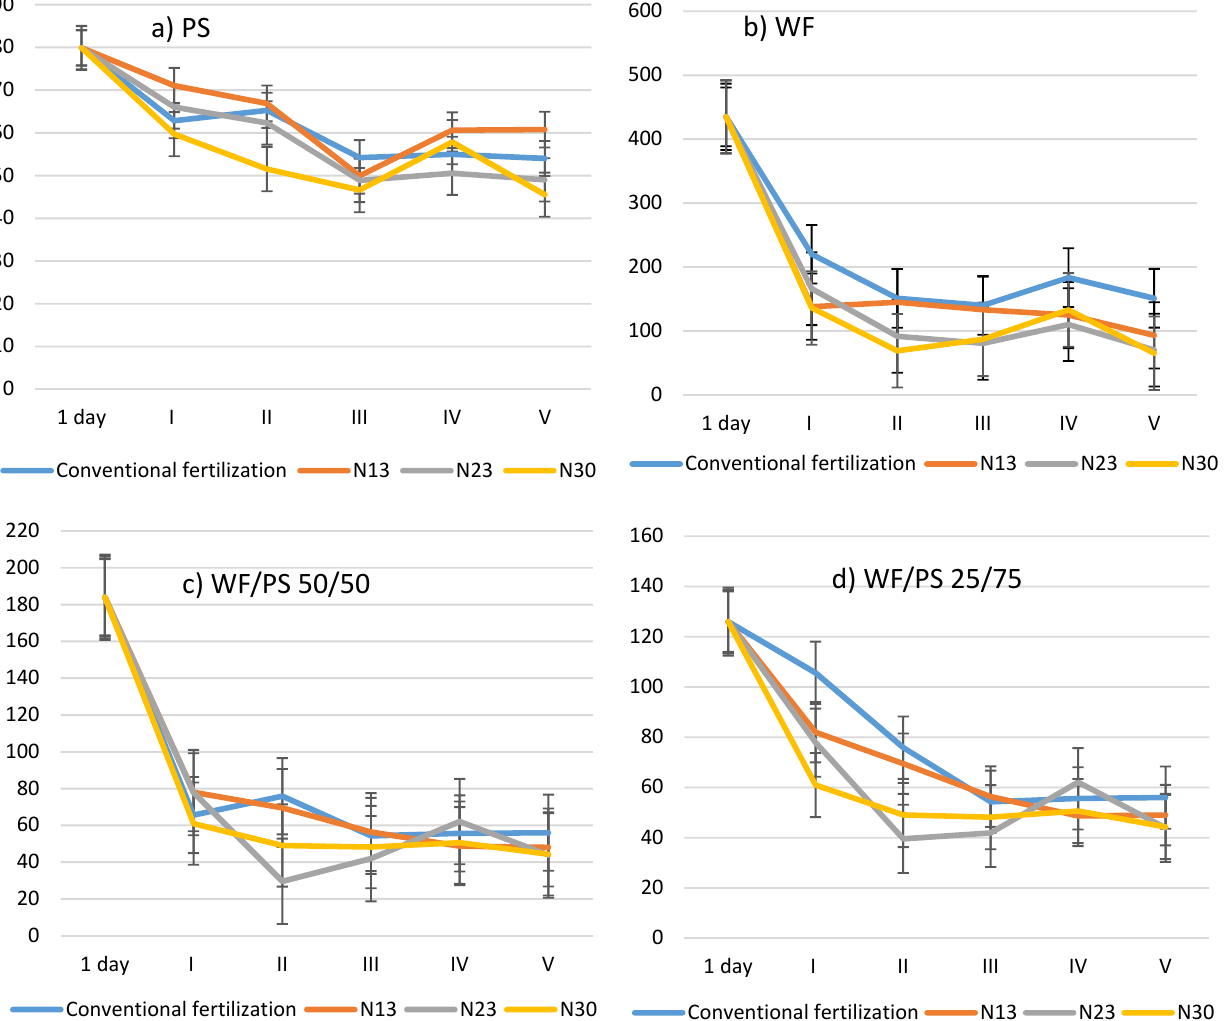
Figure 3. The influence of additional nitrogen fertilization on the variation in the carbon-to-nitrogen ratio (C:N) in growing media during the cucumber-growing season; 1 day—1 day after transplanting; I–V—five experimental stages: 27, 39, 52, 64, and 80 days after transplanting of cucumbers into the growing media. ( a ) PS—peat substrate; ( b ) WF—wood fiber; ( c ) WF/PS 50/50—mixture of wood fiber and peat substrate 50:50 v / v ; and ( d ) WF/PS 25/75—mixture of wood fiber and peat substrate 25:75 v / v . Vertical bars indicate the mean error SE; supplementary nitrogen fertilization with nitro- gen N13, N23, of N30 on the biometric parameters of cucumber.